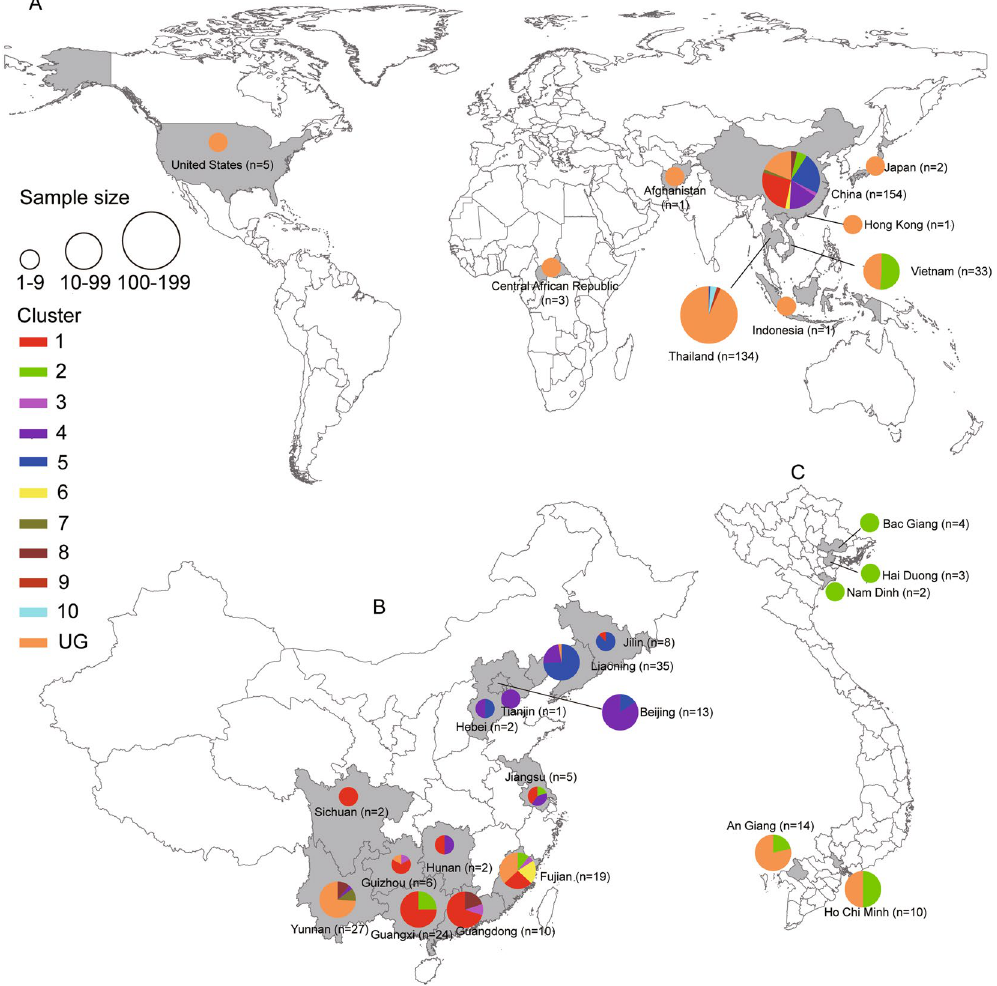
Figure. 2. Geographic distribution of HIV-1 CRF01_AE clusters identified in the present study. The geographic distribution of HIV-1 CRF01_AE clusters is shown at the ( A ) country level, and at the provincial level for ( B ) China and ( C ) Vietnam. Each CRF01_AE cluster identified in this study is color-coded, as shown on the left. Maps were obtained from Craft MAP website